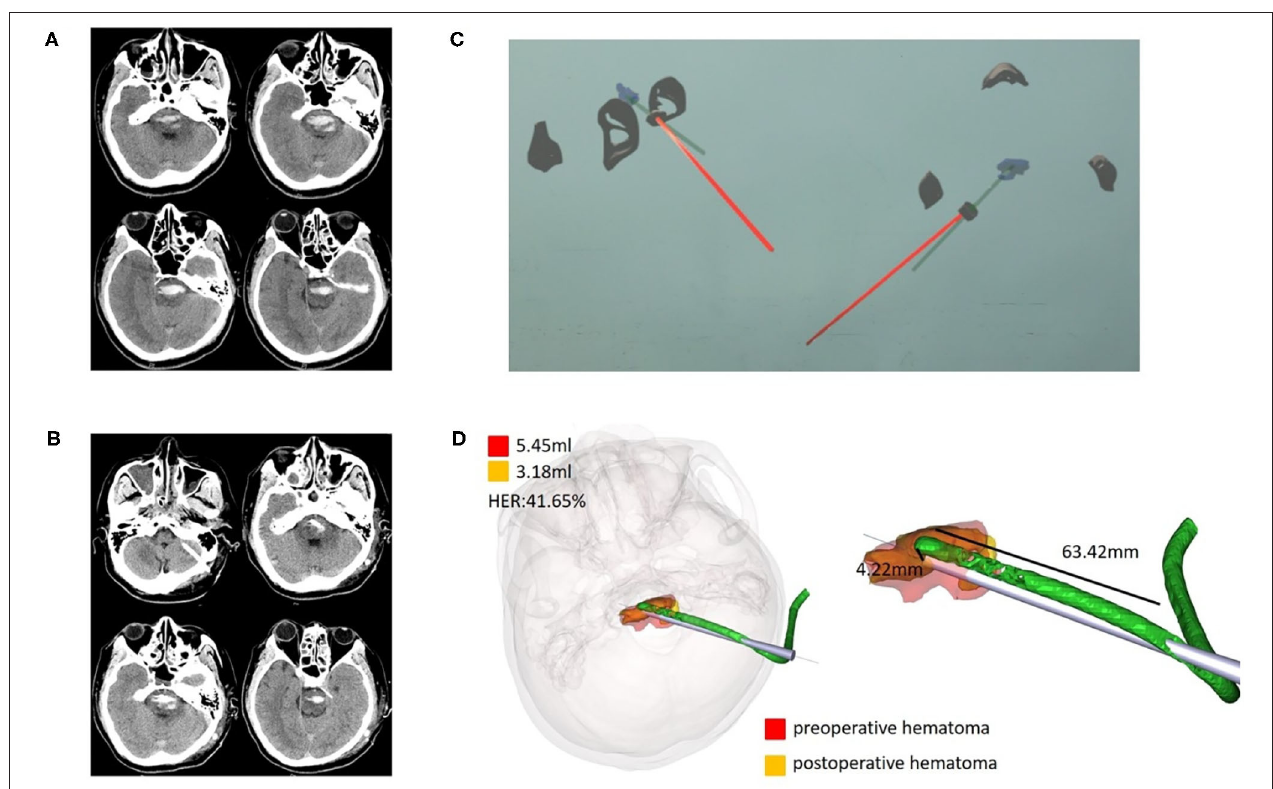
FIGURE 5 | Case 3, a 37-year-old male patient diagnosed with HICH in the brainstem. (A) Preoperative CT showed HICH in the brainstem. (B) Postoperative follow-up CT. (C) Wearing HoloLens, the sagittal and horizontal planes were adjusted for puncture through the ear and nose locations. (D) Fusion of the preoperative and postoperative three-dimensional reconstructions of the hematoma. The preoperative hematoma volume was 5.45 ml, the postoperative hematoma volume was 3.18 ml, and the hematoma evacuation rate was 41.65 % . The length of the intracranial drainage tube was 63.42 mm, and the deviation in the drainage tube target was 4.22 mm. HER, hematoma evacuation